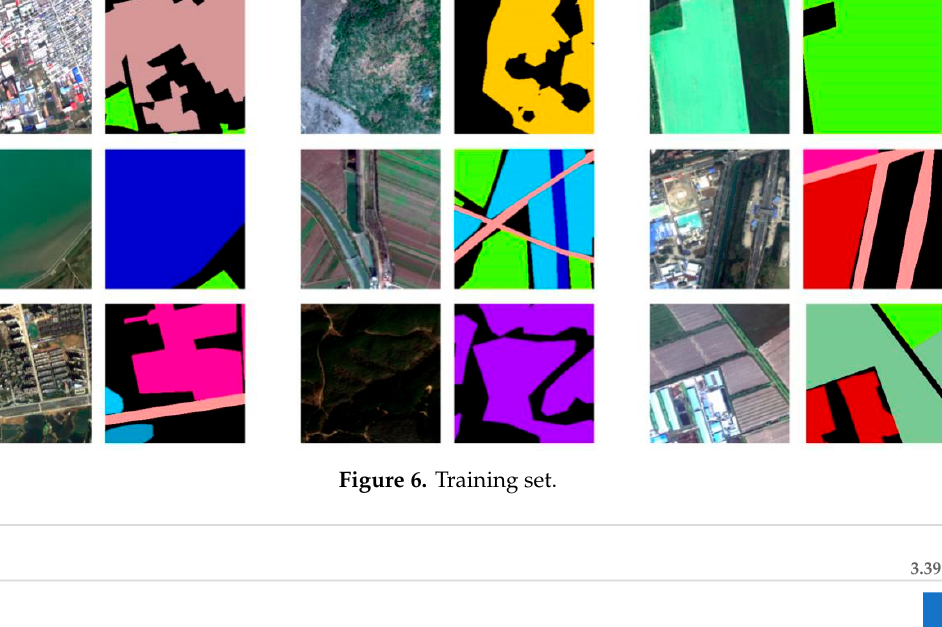
Figure 6. Training set.